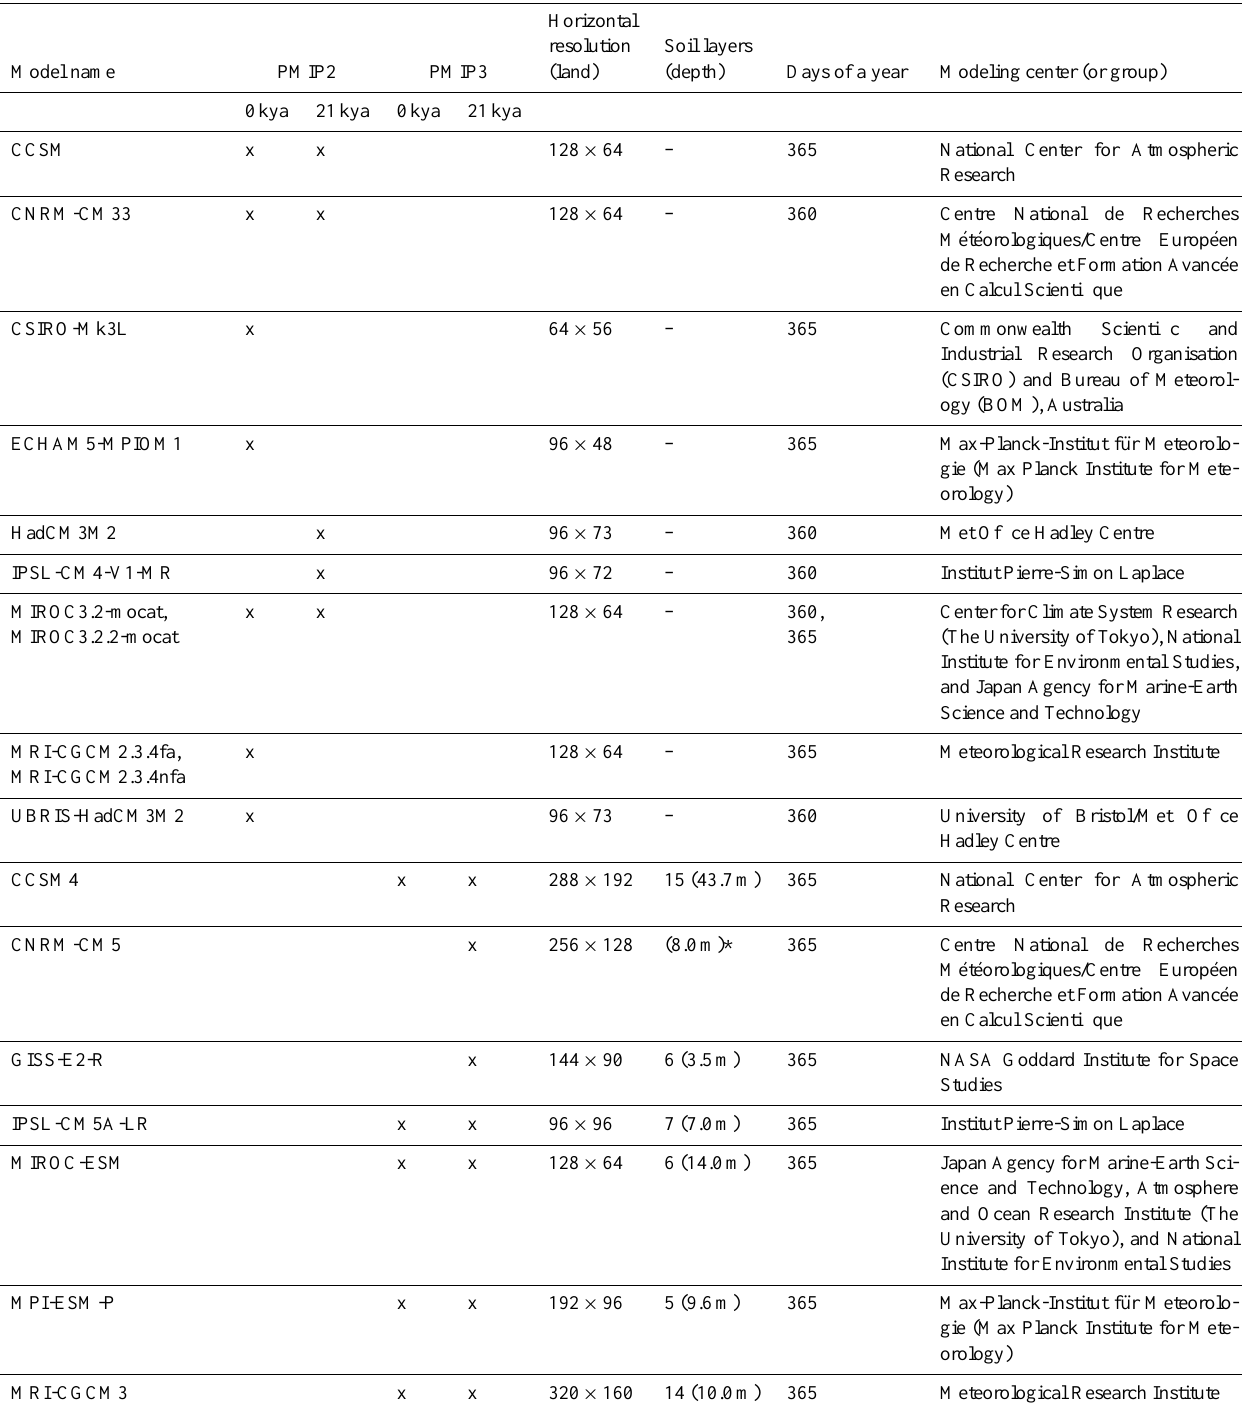
Table 1. Summary of model simulations in PMIP2 and PMIP3 used in the study. The horizontal resolution for land is given by the number of grid boxes in the longitudinal and latitudinal directions. Number of soil layers are given for PMIP3 models, followed by the depth of the total soil